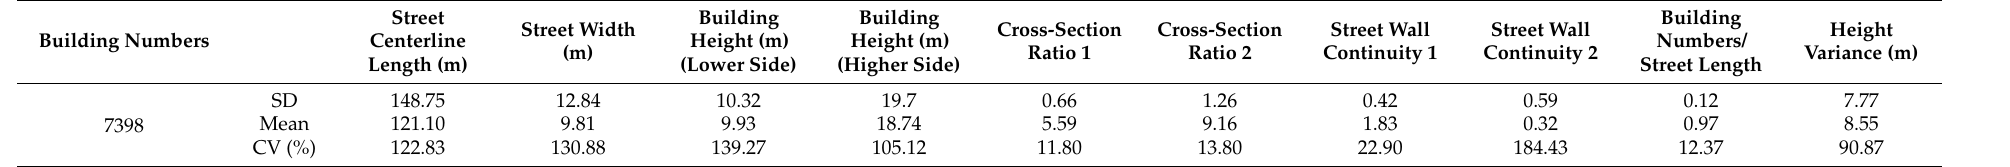
Table 3. Street space indicators of core area in downtown